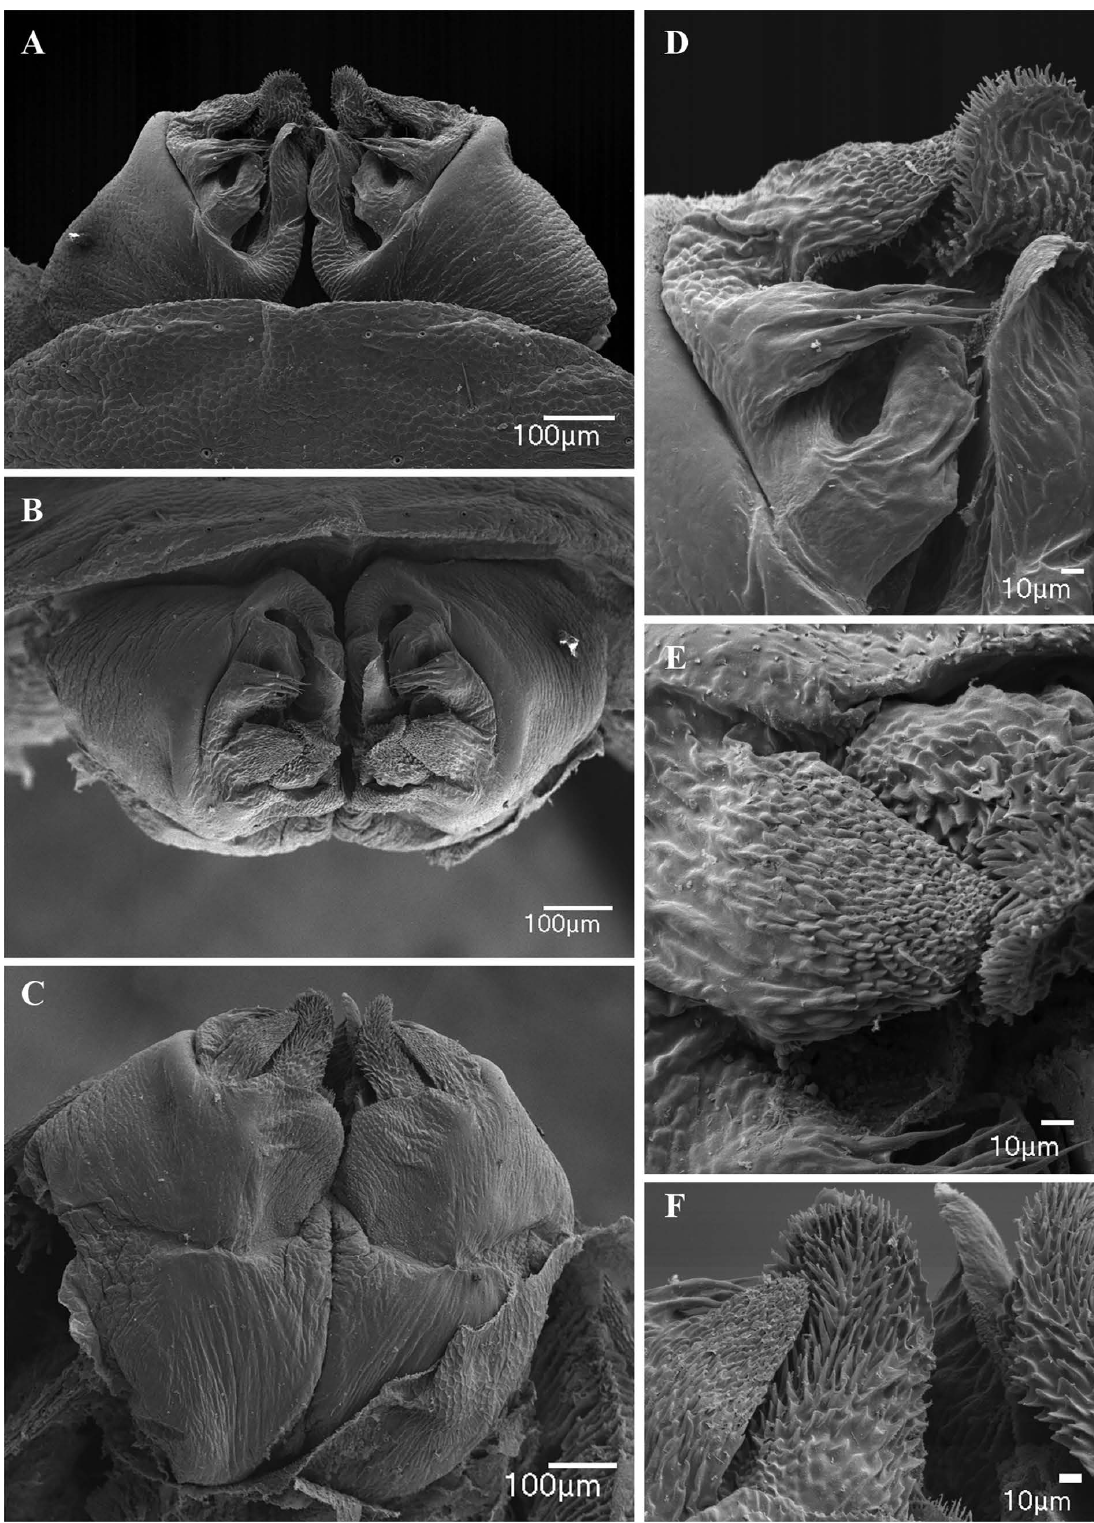
Fig. 38. Charinus insularis Banks 1902 (RBINS), male gonopod. A . Ventral view. B . Posterior view. C . Dorsal view. D . Detail of lateral lobe 1 and processus internus. E . Detail of lateral lobe I. F . Detail of lateral dorsal